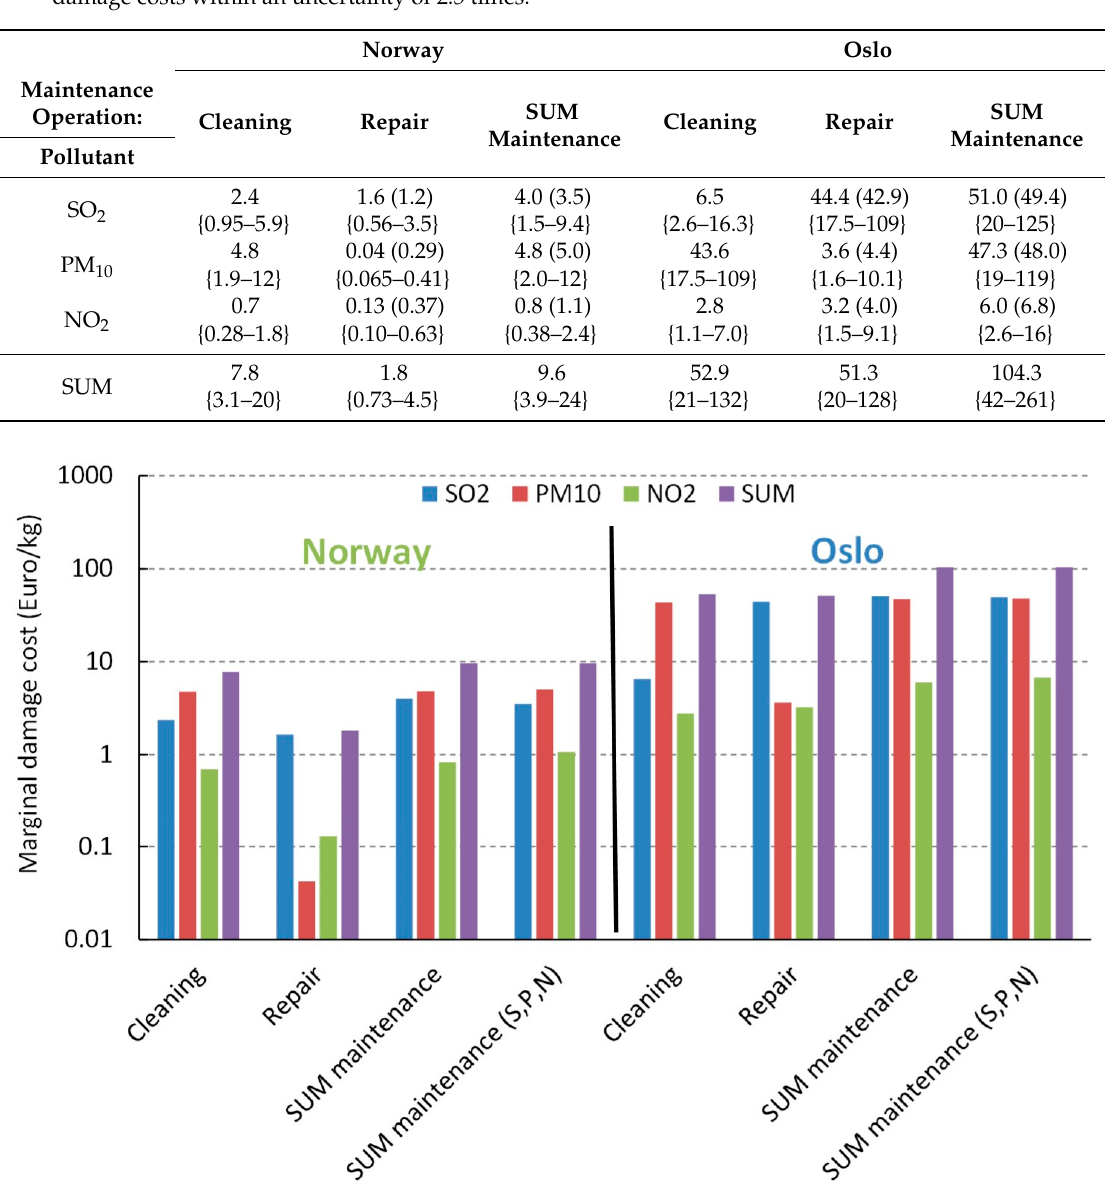
Table 6. Marginal maintenance cost for façades due to atmospheric wear per kg emission of air pollutants (Euro / kg) in Norway and Oslo. The values in round brackets () show the results if the pollution impact on the painted materials (of steel, other metals, and wood) was attributed equally to SO 2 , PM 10 , and NO 2 , rather than to SO 2 only. The values in curly brackets {} show the ranges for the damage costs within an uncertainty of 2.5 times. Norway Oslo